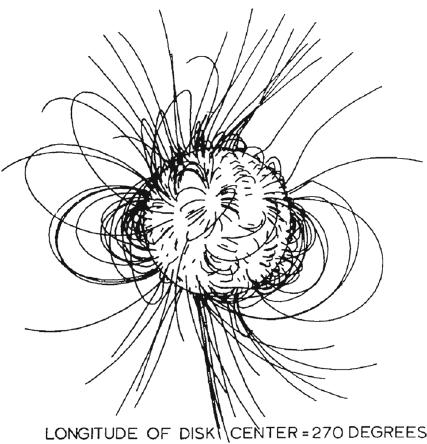
Fig. 9 Magnetic field line map obtained with the potential field source surface (PFSS) model. Image reproduced with permission from Altschuler and Newkirk (1969), copyright by